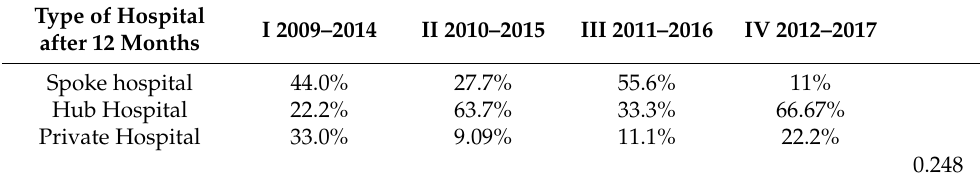
Table 1. Type of hospitals as first